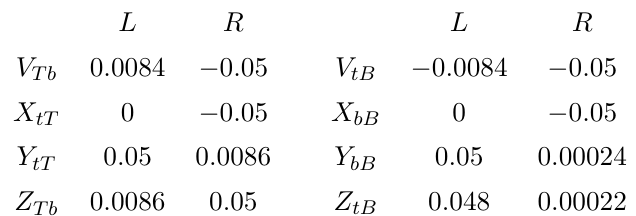
Table 1 . Couplings for the equal-mixing scenario with s u s d = 0 : 00024 for m T;B = 1 L